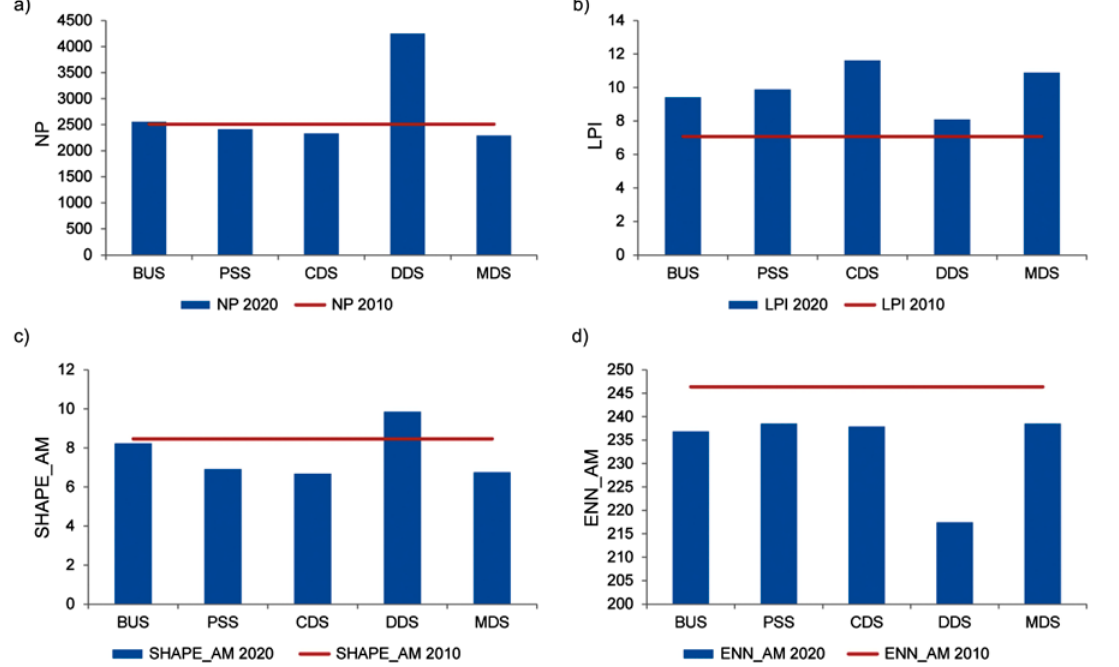
Fig. 11. Landscape metrics values of urban land use under different scenarios and observed urban landscape pattern in 2010: (a) NP value, (b) LPI value, (c) SHAPEAM value, and (d) ENN_AM value